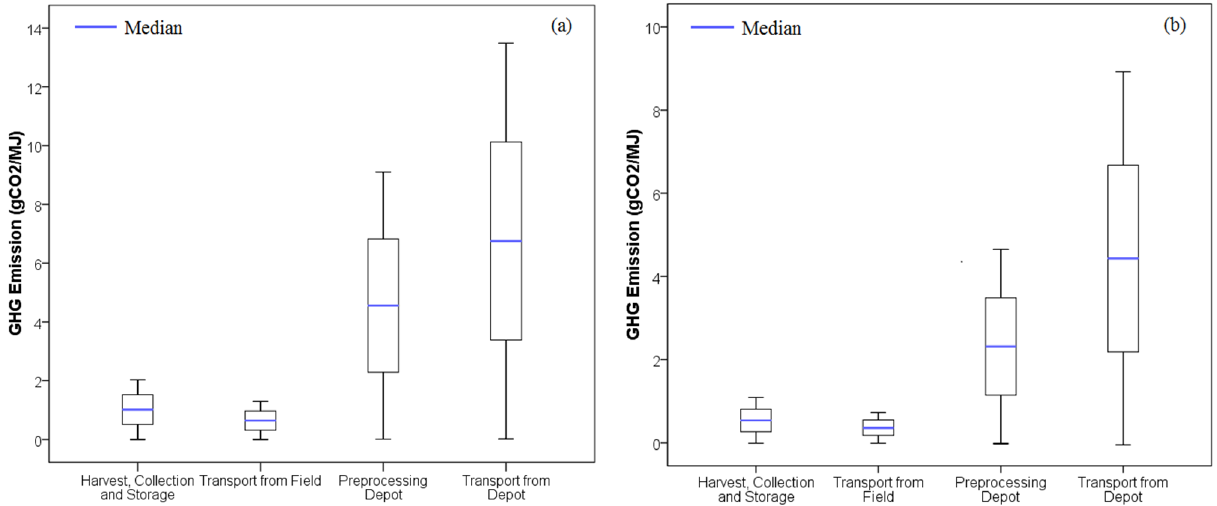
Figure 5. Stochastic gate-to-gate logistics GHG emissions over the 90% confidence interval (CI) and interquartile ranges for: ( a ) Scenario 1; and ( b ) Scenario 2. Stochastic estimates based on Monte Carlo simulation (1000 iterations) are presented as box and whisker plots. The top of the box represents the 75th percentile, the middle line represents the median (50th percentile) and the bottom of the box represents the 25th percentile. The whiskers correspond to the 5th and 95th